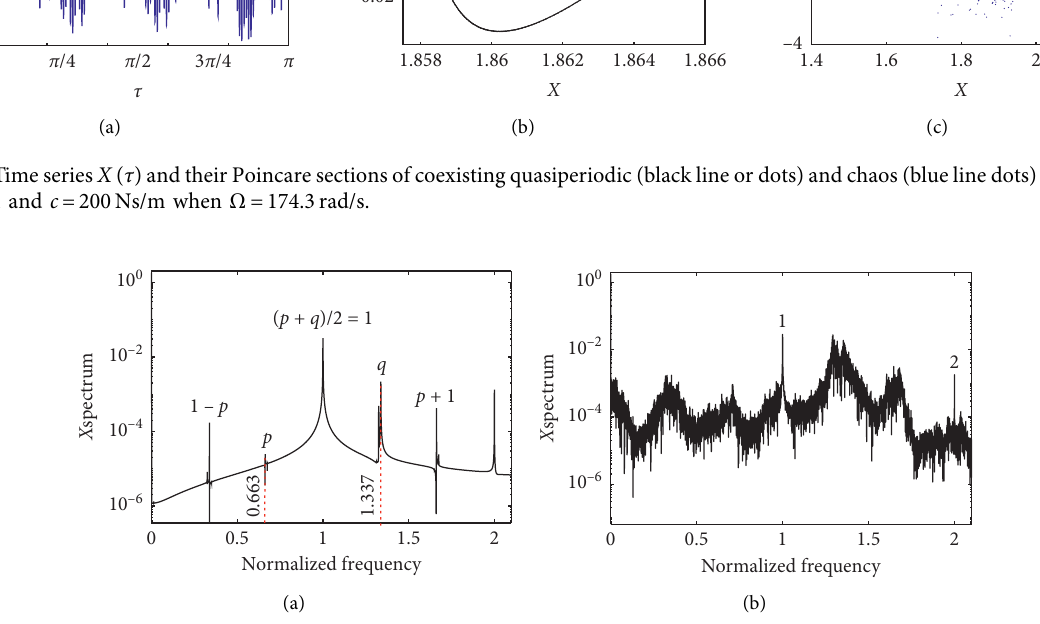
� 6.0 μ m and c � 200Ns/m when Ω � 0